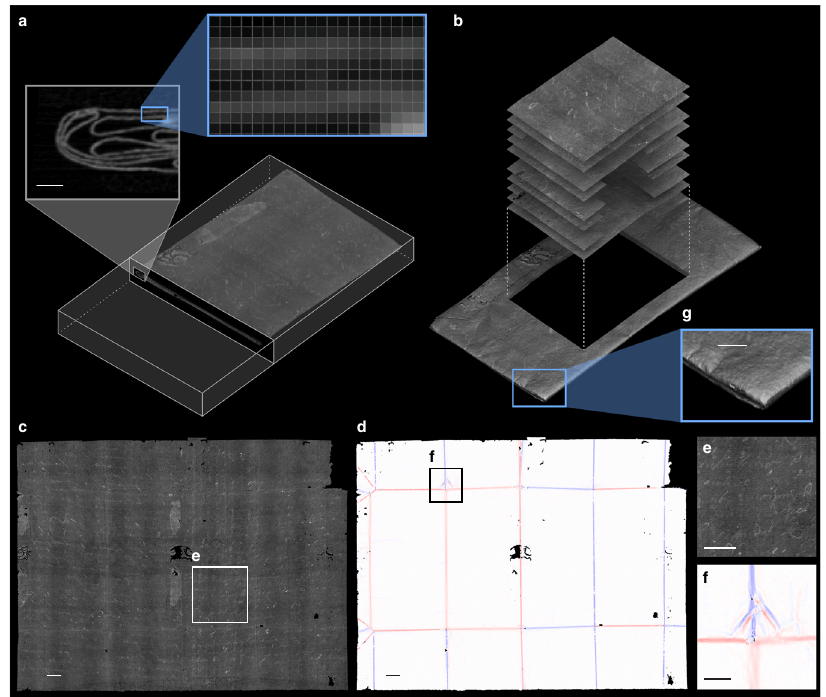
Fig. 2 Virtual unfolding overview. High-level overview of virtual unfolding showing. a XMT volumetric data and resulting b folded and c , d unfolded reconstructions of unopened letter DB-1538. c XMT scan data is mapped to 2D to produce an image of the sealed letterpacket ’ s contents. d Curvature is mapped to 2D to generate an image representing the crease pattern of the folded letterpacket. e Ink visible on the surface of the paper shows the presence of double-sided text (running both vertically and horizontally). f A close-up of the crease pattern image depicts sharp creases on the interior of the packet as thin, saturated lines, and rounded creases toward the outside of the packet as diffuse lines, due to their lower curvature spread across a larger region. Surface curvature induced by buckling of the paper near the corner of the letterpacket is also revealed by this analysis (also visible in the 3D reconstruction, f ). Scale bars: a 1 mm, c – e 10 mm, f , g 5 mm.